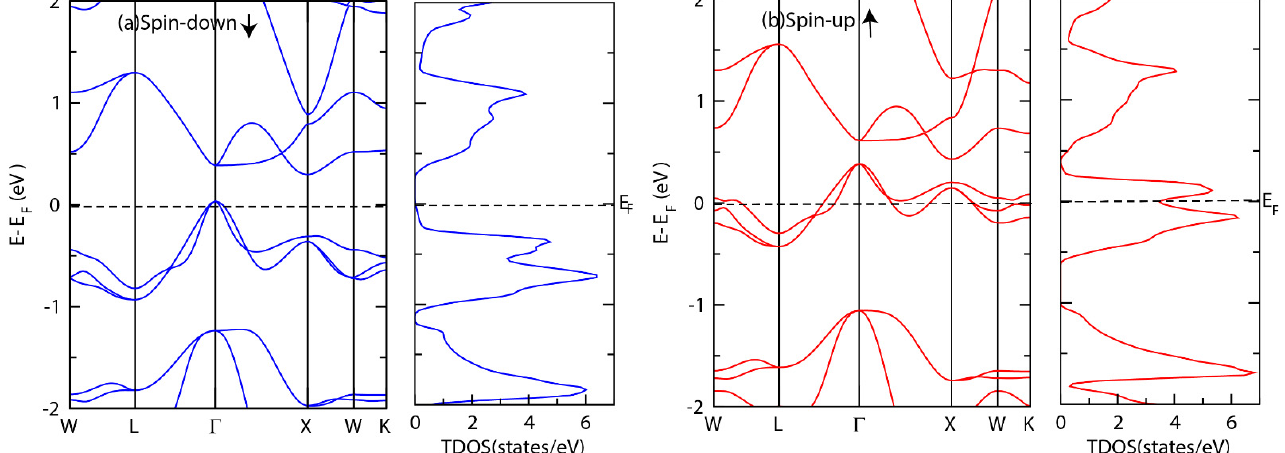
Figure 4. Electronic band structure and total density of states (TDOS) of CrTiCoSi in ( a ) the spin up channel and ( b ) the spin down channel.